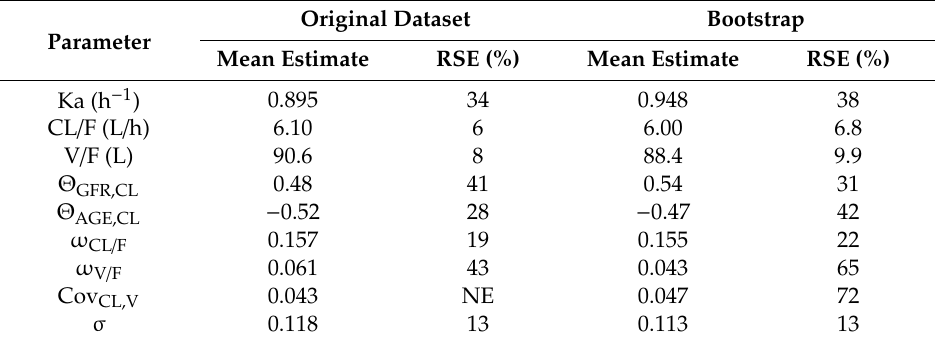
Table 2. Mean parameter estimates and relative standard deviations for the final model.